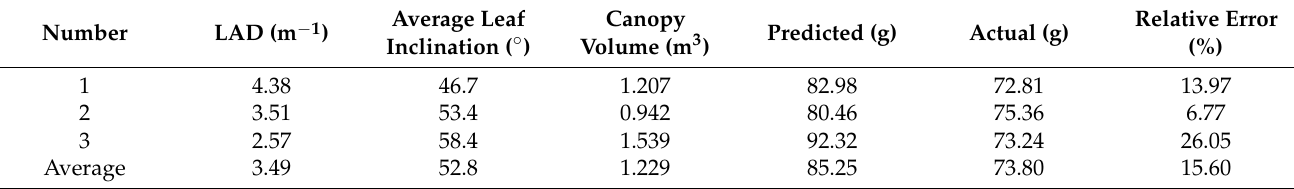
Table 15. Comparison table of experiment results and predicted